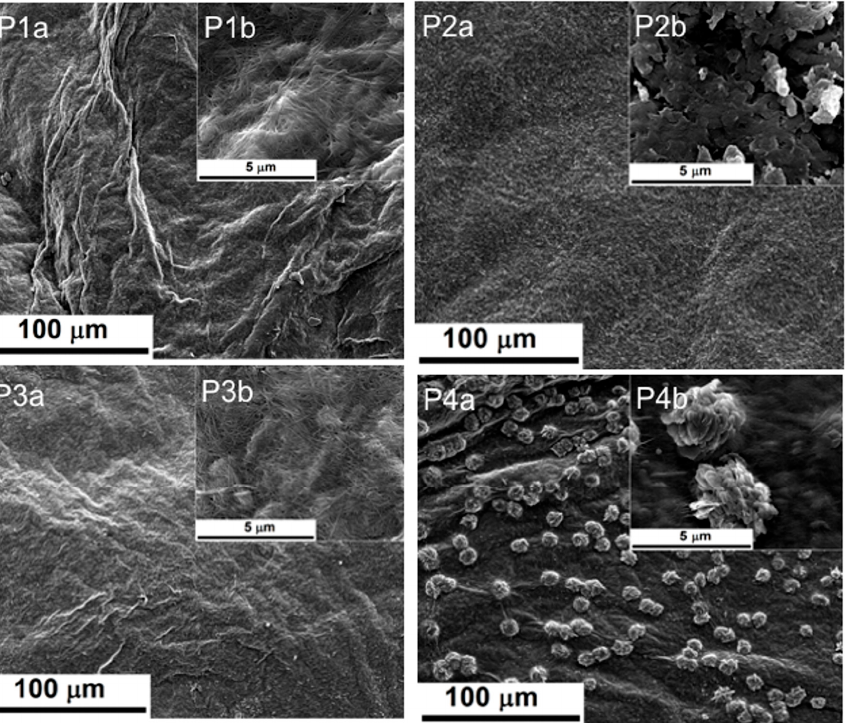
Figure 1. SEM images of P1–P4 samples at different magnifications: ( a ) P1a–P4a (1000 × ); ( b ) P1b–P4b (30,000 ×